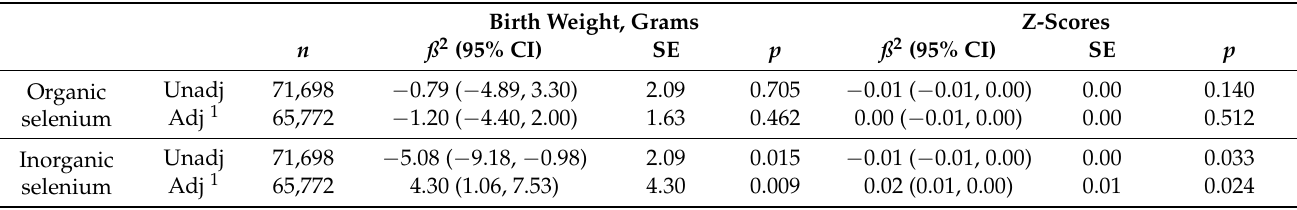
Table 4. Associations between maternal selenium intake from supplements and birth weight in 71,728 women from the Norwegian Mother, Father and Child Cohort study.